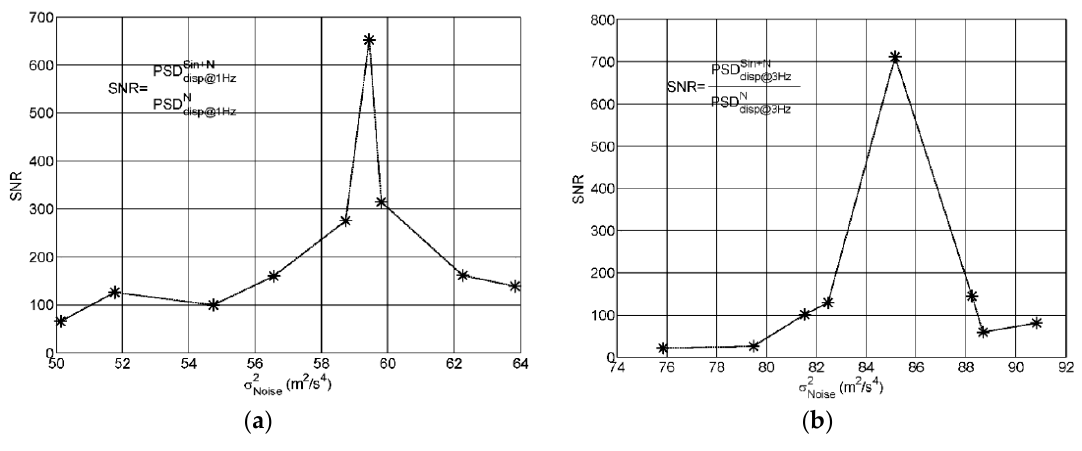
Figure 2. The Signal to Noise Ratio (SNR) vs the variance of the superimposed noise limited at 100 Hz, in case of a subthreshold deterministic input at ( a ) 1 Hz and ( b ) 3 Hz. As expected an optimal value of the noise level, σ opt , maximizes the